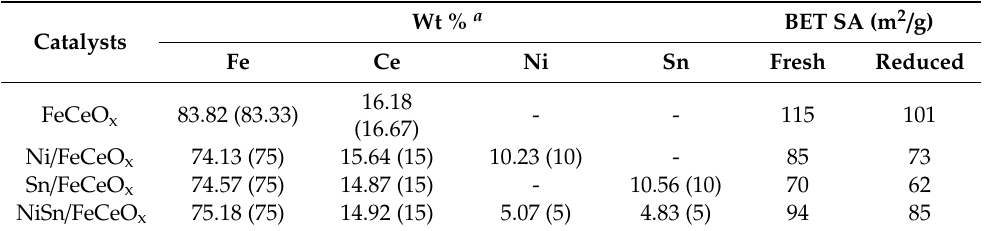
Table 2. Composition and Brunauer-Emmett-Teller (BET) surface area of FeCeO x , Ni / FeCeO x , Sn / FeCeO x , and NiSn / FeCeO x